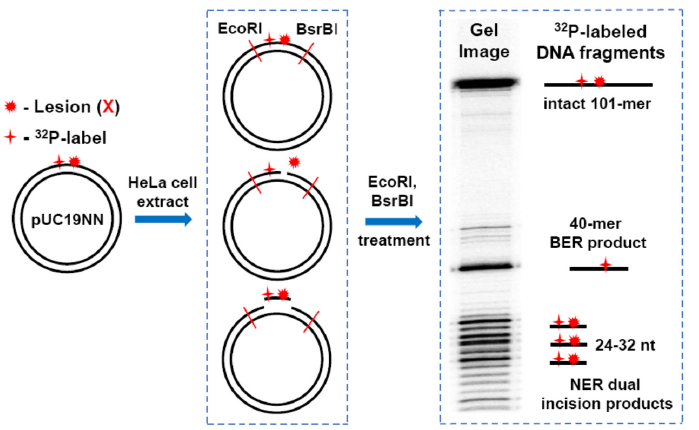
Figure 3. Schematic summary of the analysis of products derived from the incisions of covalently closed circular plasmids by BER and NER mechanisms after incubation in human cell extracts